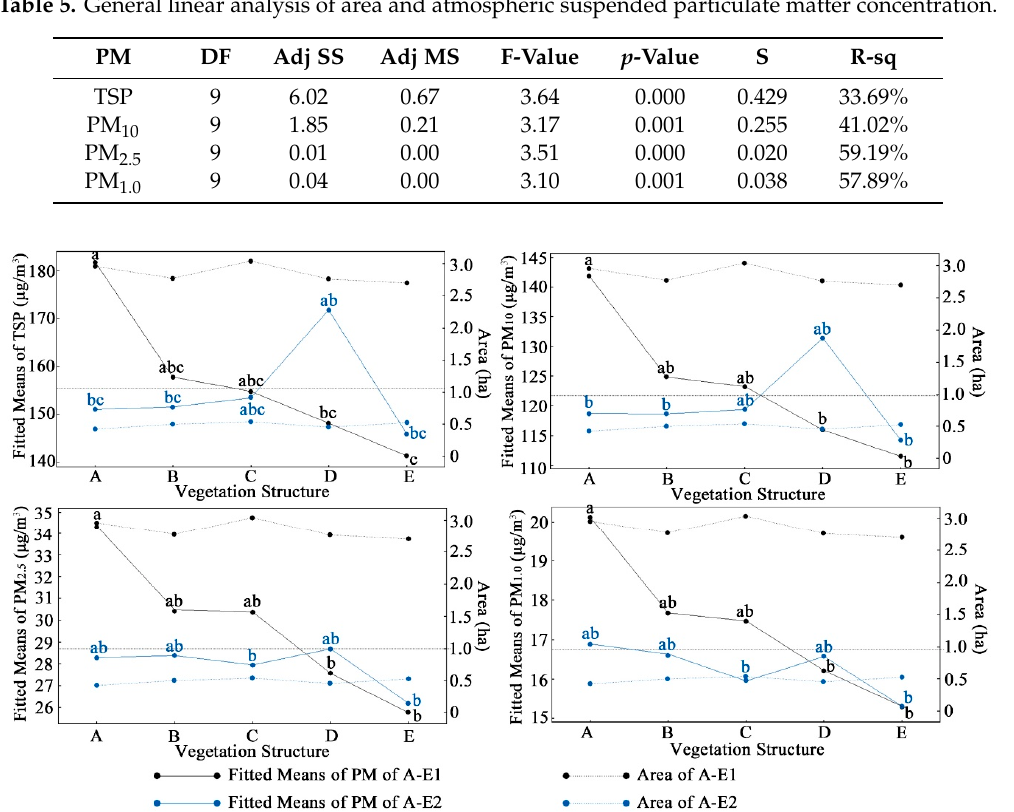
Table 6. Plant species information for each plot.